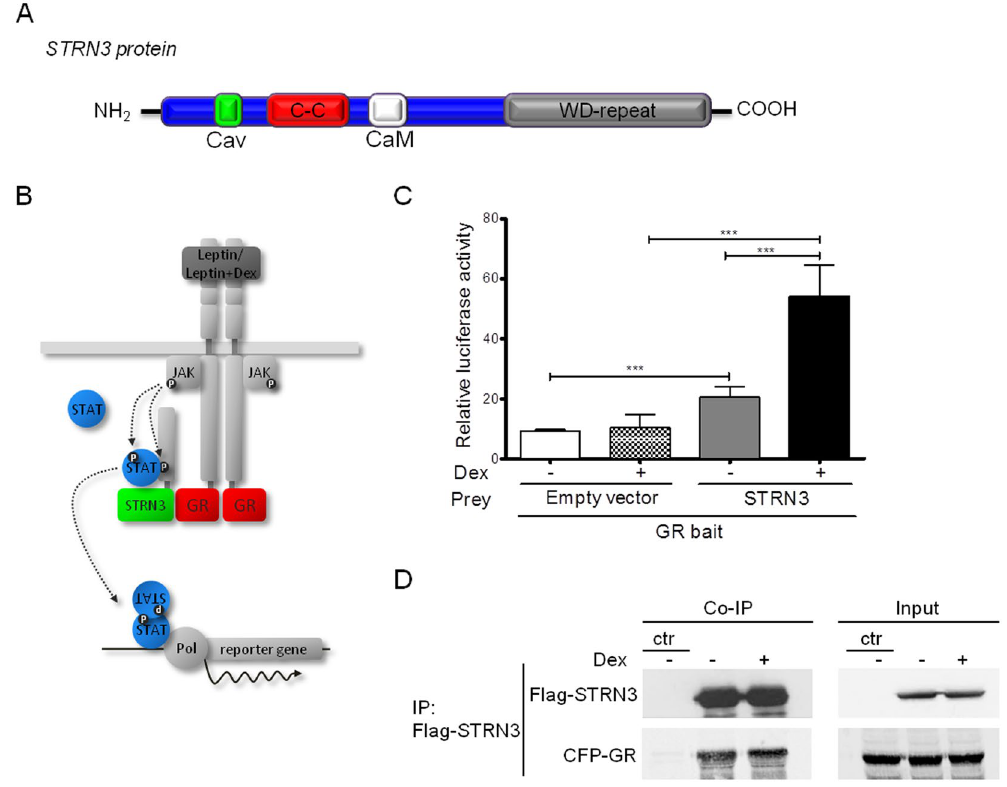
Figure 1. STRN3 is a novel interaction partner of the Glucocorticoid receptor. ( A ) Protein structure of STRN3. Depicted are its representative domains i.e. the Caveolin-binding domain (CaV), the coiled-coil domain (C-C), the Calmodulin-binding domain (CaM) and the tryptophan-aspartate (WD)-repeats at its C-terminal domain. ( B ) Schematic representation of MAPPIT technology. GR is fused to a mutated Leptin receptor, unable to recruit STAT3. The STRN3 pray is bound to a gp130 fragment with functional STAT3 recruitment sites. Only upon interaction of GR with STRN3 and stimulation with Leptin or Leptin + Dex, the Leptin receptor signaling cascade is reconstituted, leading to STAT3 activation, translocation to the nucleus and activation of the reporter gene (luciferase). ( C ) For the MAPPIT experiments, HEK293T cells were transfected with GR bait, rPAP1-Luc reporter and STRN3 prey or empty vector and stimulated with vehicle (medium, not shown in the graph) or leptin plus medium ( − ) or with leptin plus Dex ( + ) for 24 h (more details in Methods). The graphs represent the fold change induction to the vehicle-treated condition. Empty vector was used as negative control. The graph represents pool data from three independent experiments. ( D ) The interaction of GR with STRN3 was confirmed with co-immunoprecipitation (Co-IP). HEK293T cells were transfected with 3 μ g Flag-STRN3 (96 kDa) and 4 μ g of CFP-GR (117 kDa) (or empty vector so that total transfected DNA is 7 μ g) and stimulated either with vehicle (media) or with 1 μ M Dex for 2 h. Cells were lysed and immunoprecipitated with M2-Flag beads. Over-expression of CFP-GR with M2-Flag beads incubation was used as negative control for the IP assay. Precipitates and input lysates were immunoblotted for GR and Flag. The blots show one representative experiment out of three performed (full-length blots are provided in Supplementary STRN3 inhibits the transactivation function of other nuclear receptors. As STRN3 was previously described to reduce the activity of ER α 25 , we asked whether the observed effect of STRN3 was specific for the steroid receptor class of nuclear receptors, or else could be expanded to other nuclear receptor family members. Hereto, we compared the effect of STRN3 over-expression on progesterone-driven PR activity (Fig. 4A) and on GW647-driven PPAR α activity (Fig. 4B), using their respective promoter elements coupled to luciferase report- ers. In analogy with the results using GR, upon over-expression of STRN3 the ligand-mediated transactivation ability of both receptors is decreased. For PR, a decrease of 24% was observed and an even more prominent effect, almost 50%, is obtained for activated PPAR α -driven PPRE-Luc activity (Fig. 4B). Already at the lowest concen- tration of transfected plasmid DNA, STRN3 was able to significantly inhibit PPAR α transactivation. STRN3 decreases GR transactivation via the dephosphorylation of serine S211. In human GR, phosphorylation of serine 211 (S211, mouse S220, rat S232) in its N-terminal domain is linked to receptor trans- activation 26 (Fig. 5A). Since we identified a STRN3-mediated decrease of GR transactivation, it was tempting to speculate that STRN3 may alter the phosphorylation status of S211 of human GR. Over-expressing increasing amounts of STRN3 in A549, as indicated, resulted in a gradual decrease in the cellular pool of GR, specifically